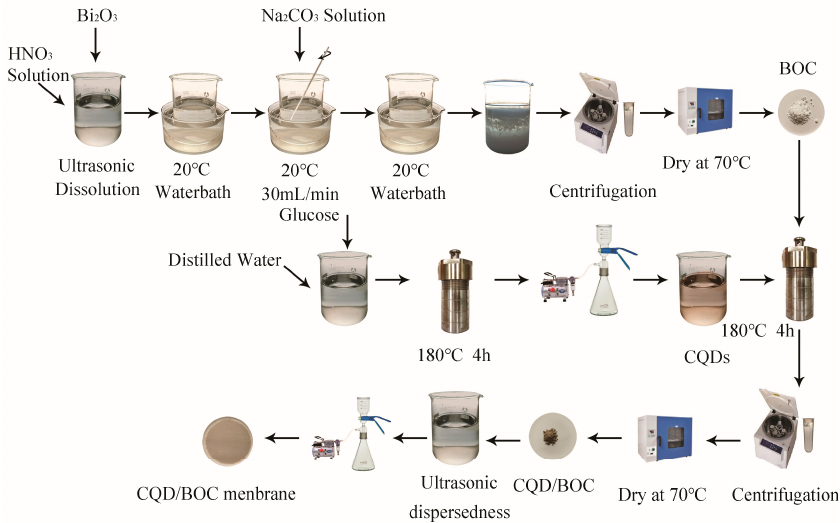
Figure 1. Chemical route for the preparation of carbon quantum dots (CQD)/Bi 2 O 2 CO 3 (BOC)